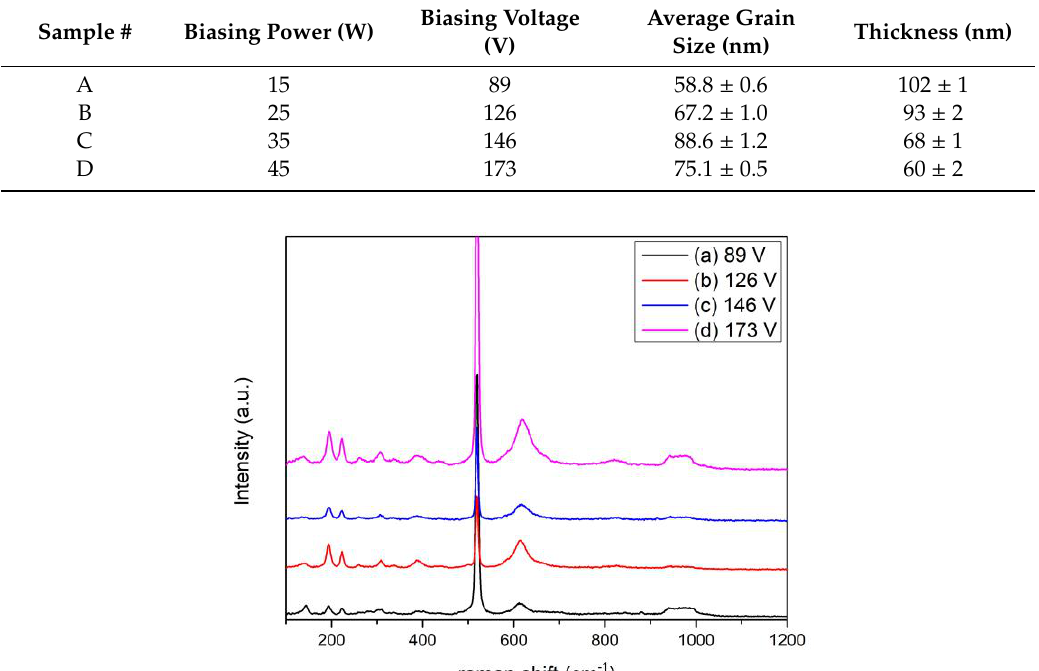
Table 1. Grain size and thickness of the as-deposited VO 2 thin films with substrate biasing.